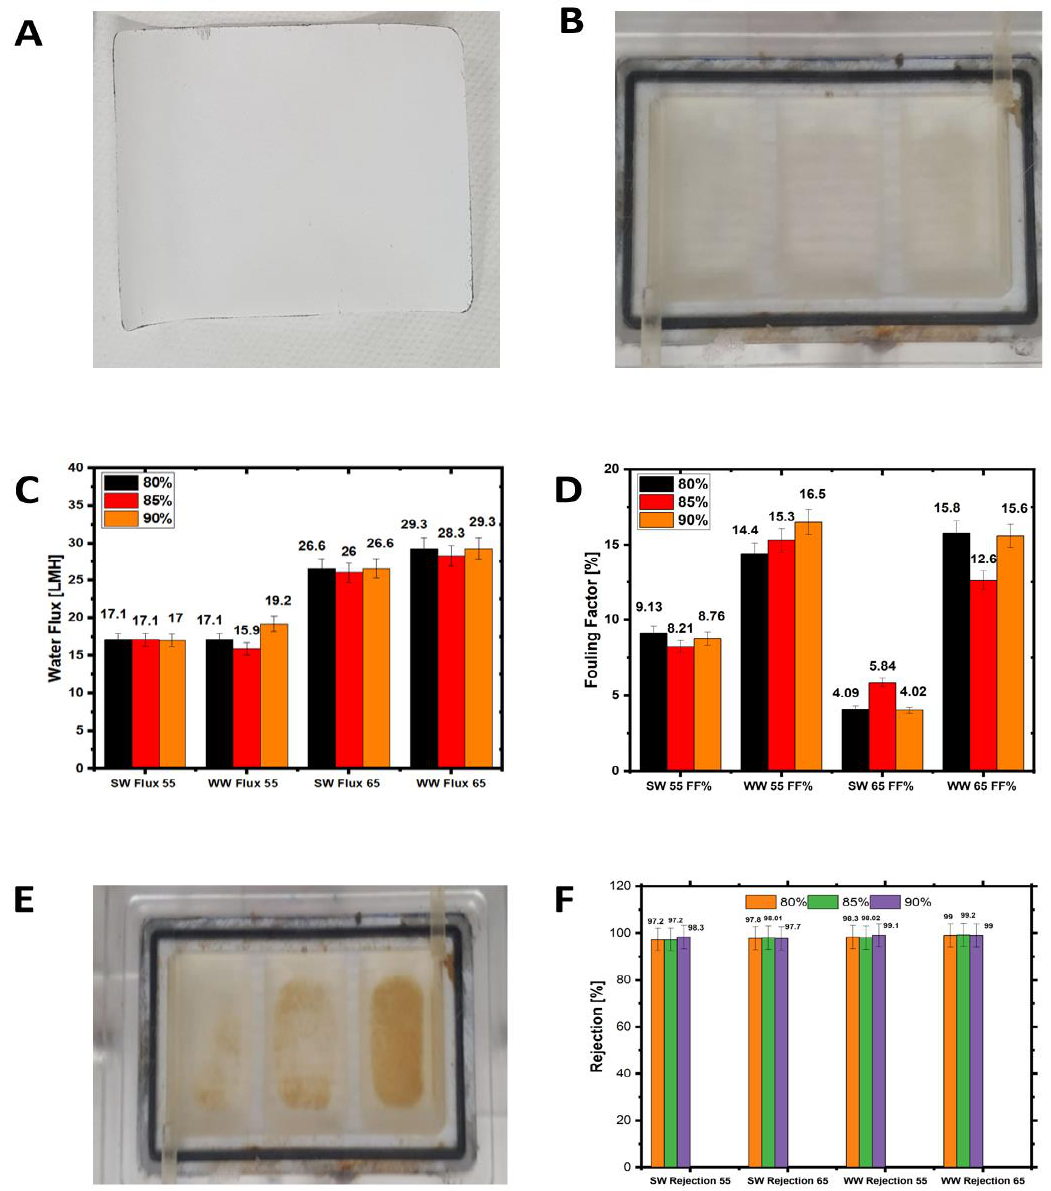
Figure 10. ( A ) Pristine membrane picture, ( B ) PTFE membrane after seawater treatment picture, ( C ) seawater average water flux with the fouling factors at 55 ° C and 65 ° C for all recoveries, ( D ) wastewater and seawater fouling factors at 55 ° C and 65 ° C for all recoveries, ( E ) picture of fouled wastewater membrane, and ( F ) comparison of seawater and wastewater rejection at 55 ° C and 65 ° C for all recovery rates.